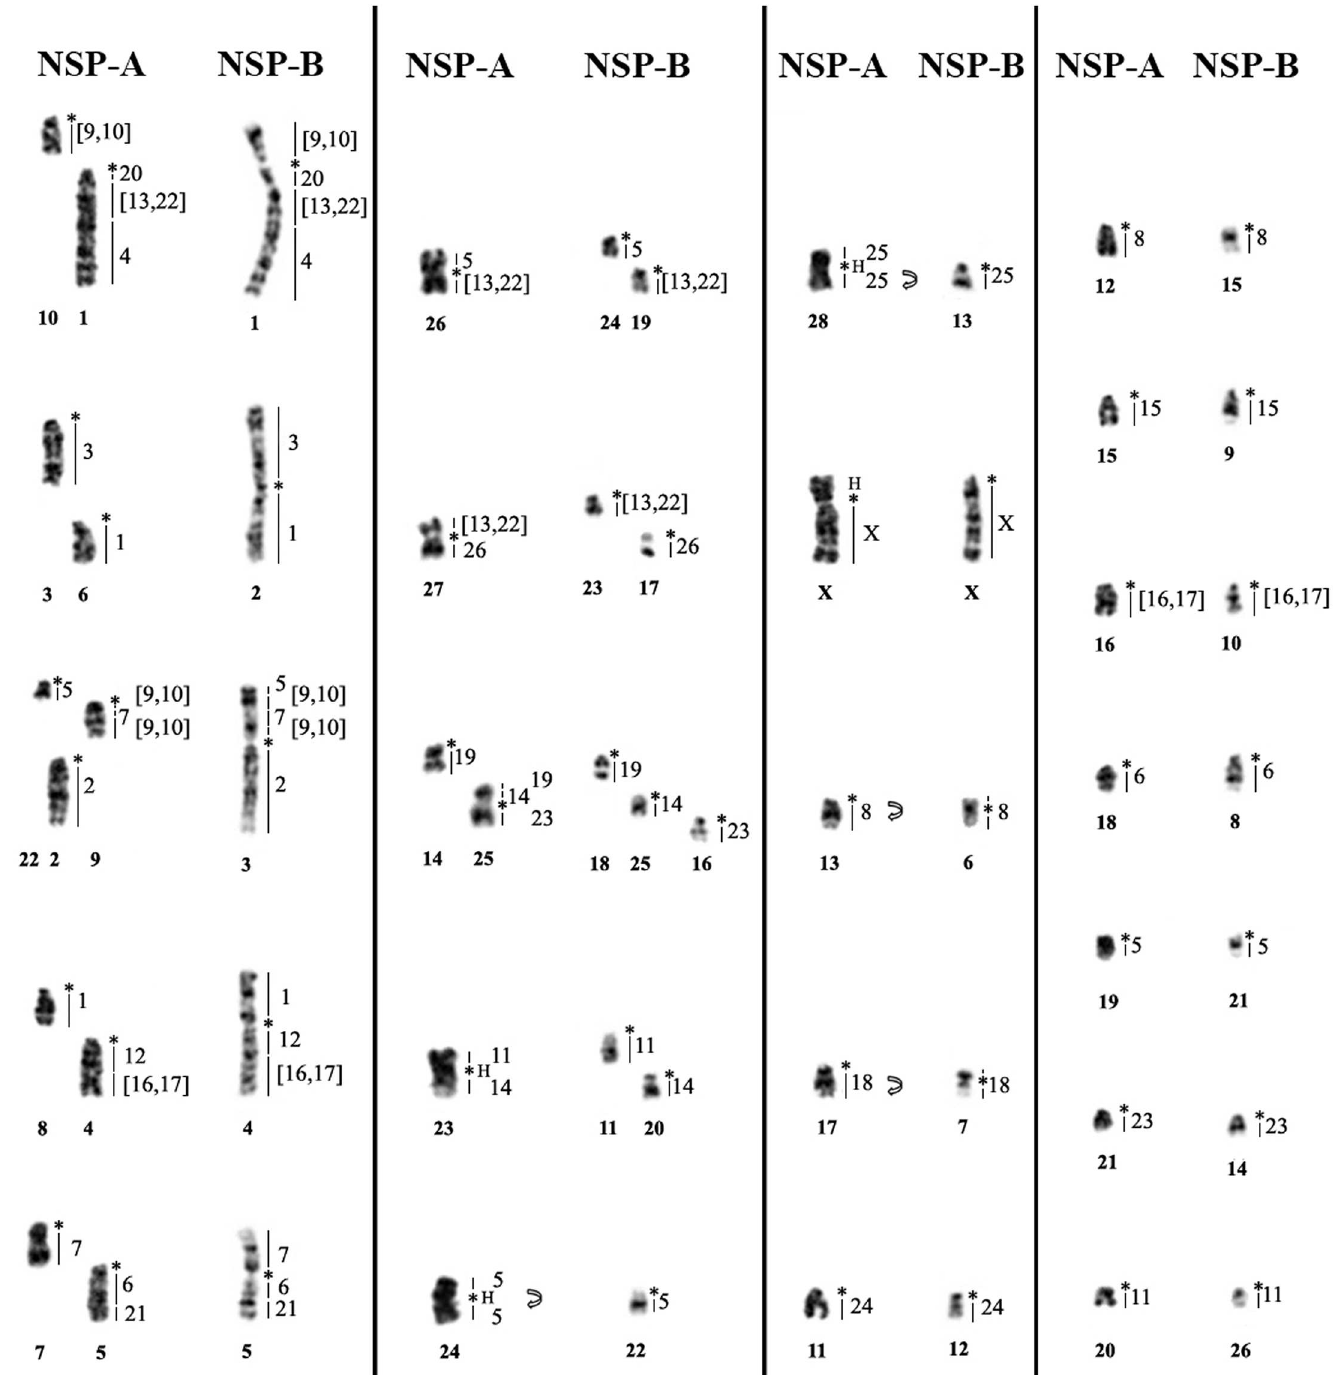
Fig 8. Comparative analysis by G-banding and ZOO-FISH with HME whole chromosome probes [20], between Neacomys sp. A and Neacomys sp. B. (H) Large block of constitutive heterochromatin. ( * ) Indicates centromere. Curved arrow indicatespericentricinversion.